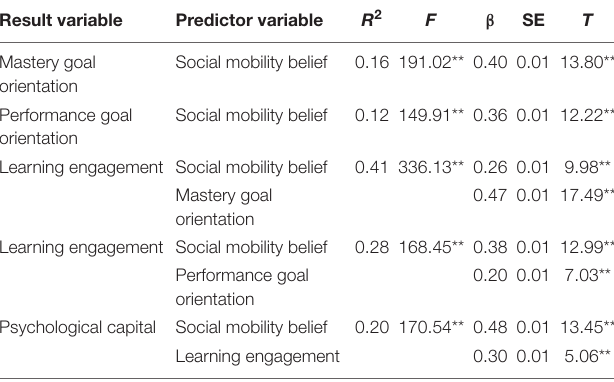
TABLE 3 | The mediating effect of achievement goal orientation and psychological